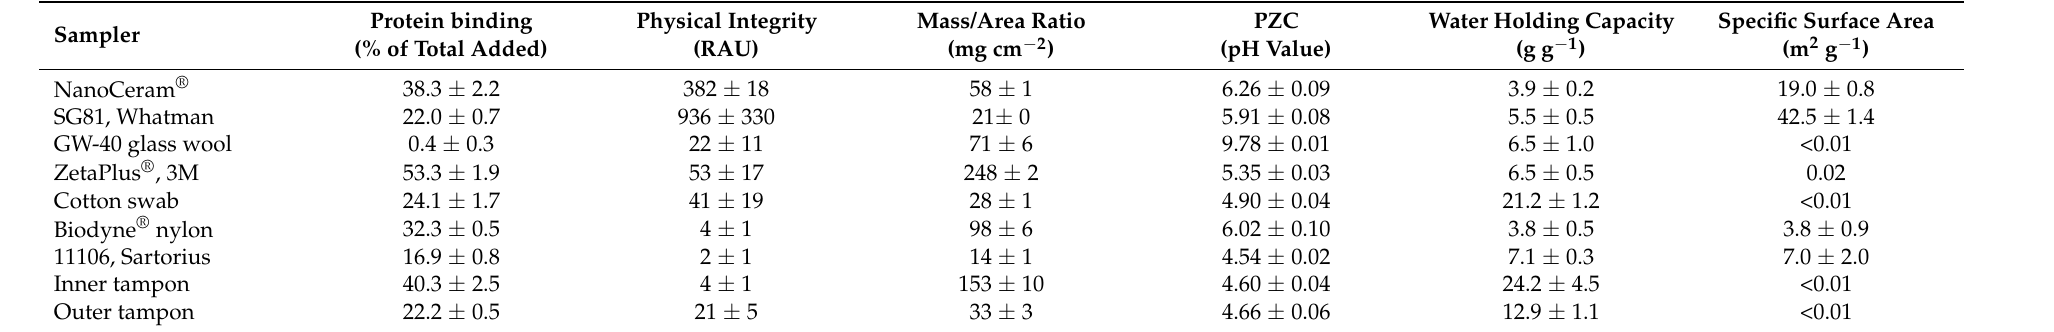
Table 4. Basic physical and chemical characteristics of the passive sampler materials used in the trials. Values represent means ± SEM ( n =